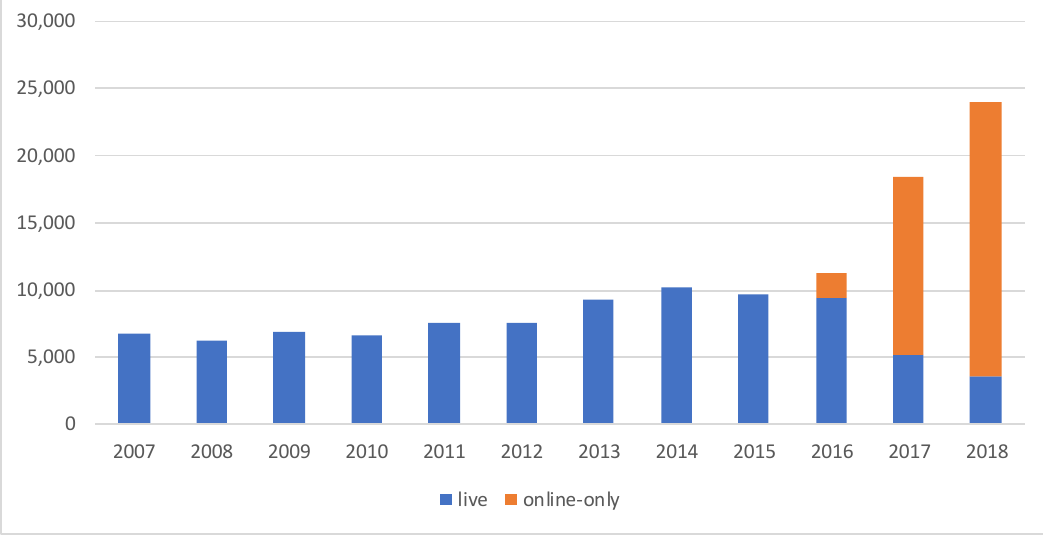
Figure 6. Total number of lots taken to auction (live and online-only) (2007 – 2018).